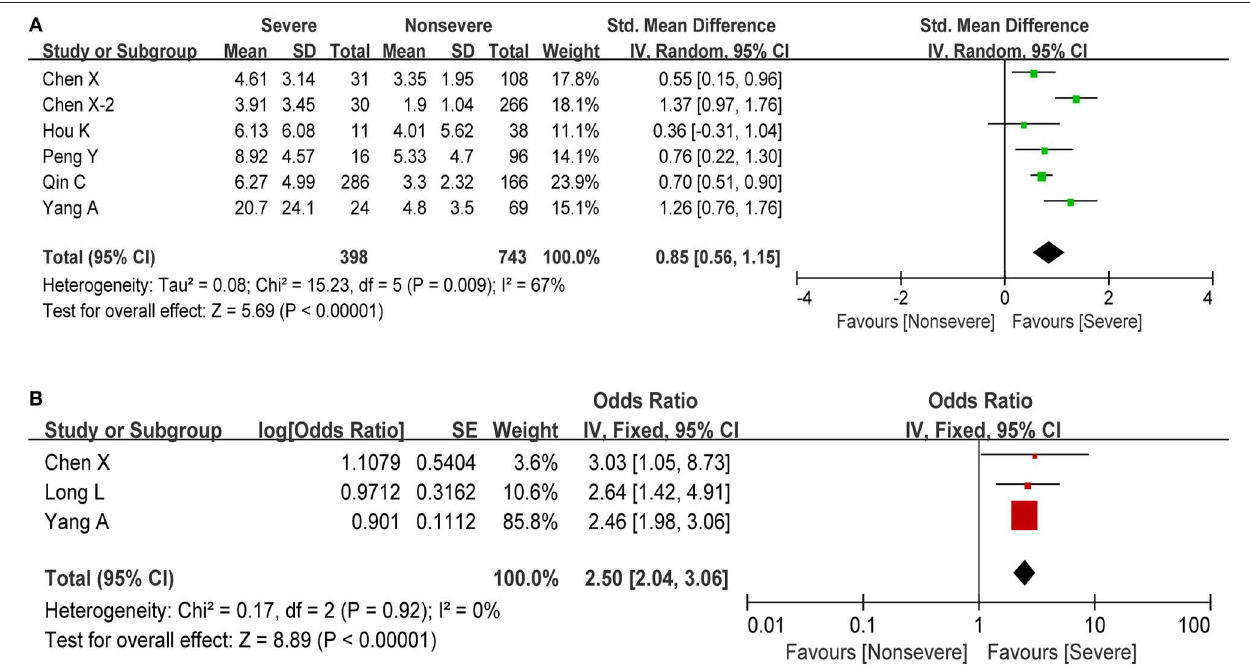
FIGURE 4 | Meta-analysis for NLR in COVID-19 cases. (A) Forest plot of mean difference in NLR. (B) Forest plot of OR for the correlation of elevated NLR with disease severity.